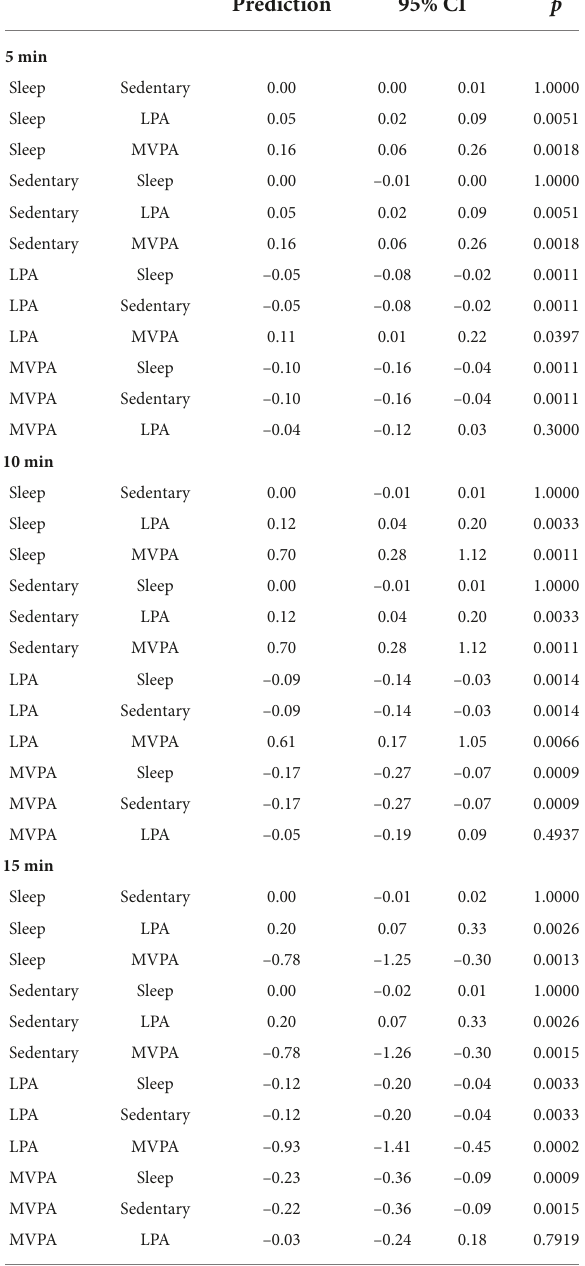
TABLE 2 Estimated differences in anxiety symptoms scores changes among reallocations sleep, sedentary behaviour and physical activity.